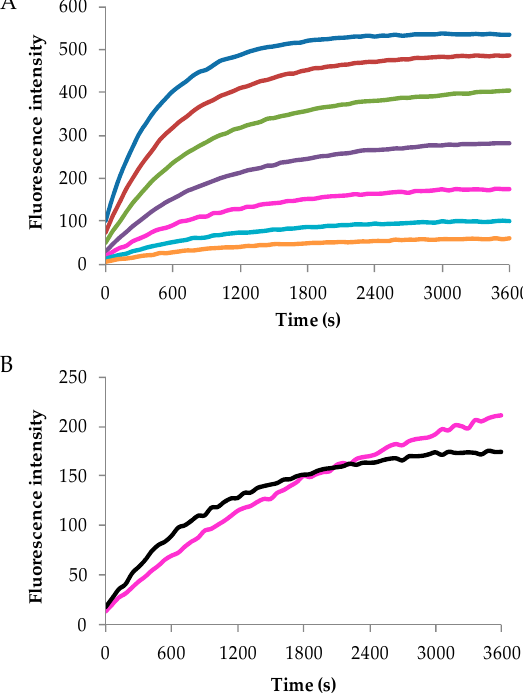
Figure 8. The fluorescence progress curves of the unbound or conjugated elastase substrate upon detecting the release of 7-amino-4-methylcoumarin triggered through serine protease human neutrophil elastase (HNE) at 0.5 U/mL (37 ◦ C). ( A ) Calibrated curves of the unbound elastase substrate at 1 µ M (blue), 0.5 µ M (red), 0.25 µ M (green), 0.13 µ M (purple), 0.06 µ M (pink), 0.3 µ M (turquoise) and 0.015 µ M. ( B ) The response curves of the unbound elastase peptide substrate (standard 0.06 µ M, black) and 2 mg of the PepNA biosensor (pink).